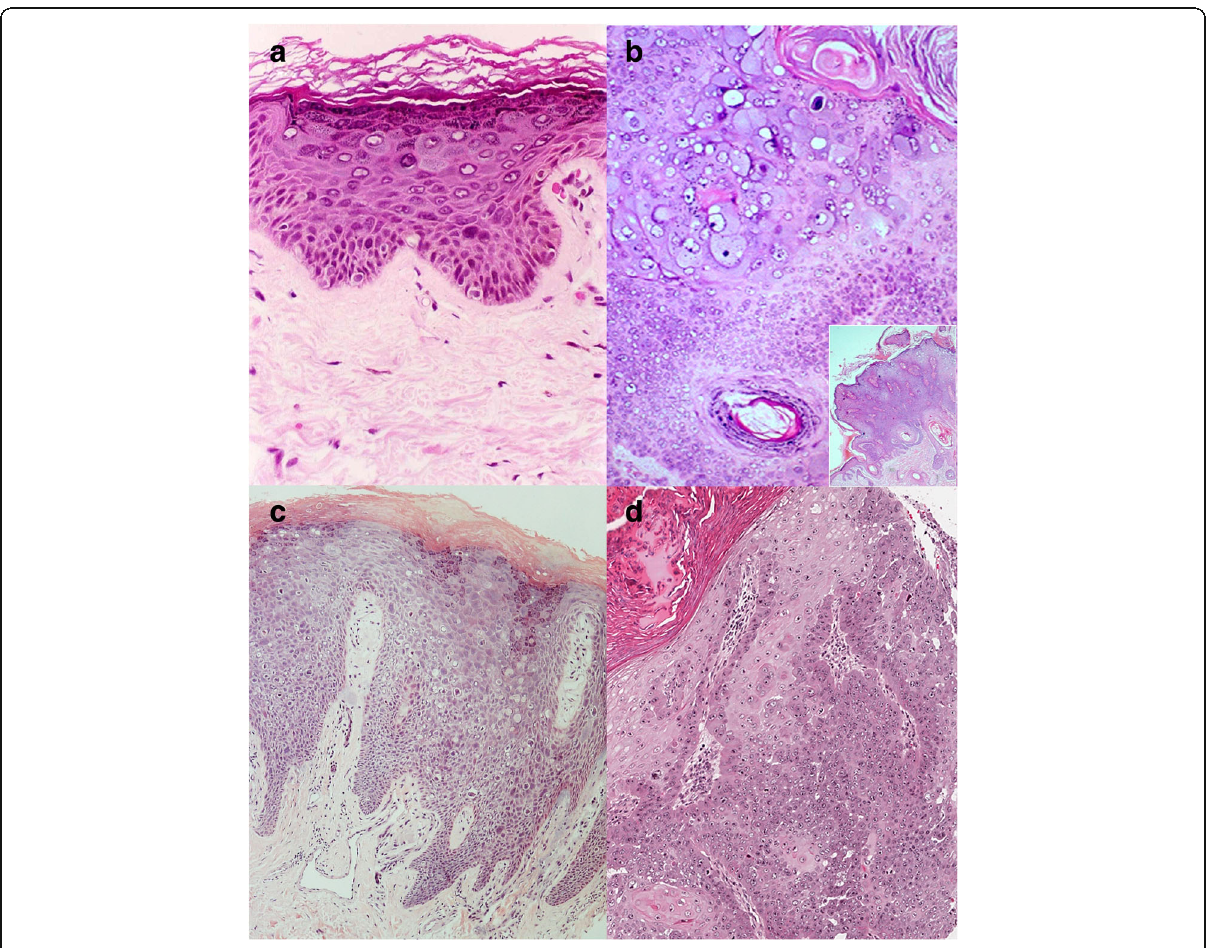
Fig. 3 Examples of cytopathic effect in epidermodysplasia verruciform (EV) in different skin lesions. a Flat wart (Hematoxylin-eosin- HE, × 400). b Seborrheic keratosis (HE, × 400). c In situ squamous cell carcinoma (HE, × 200). d Invasive squamous cell carcinoma (HE, ×